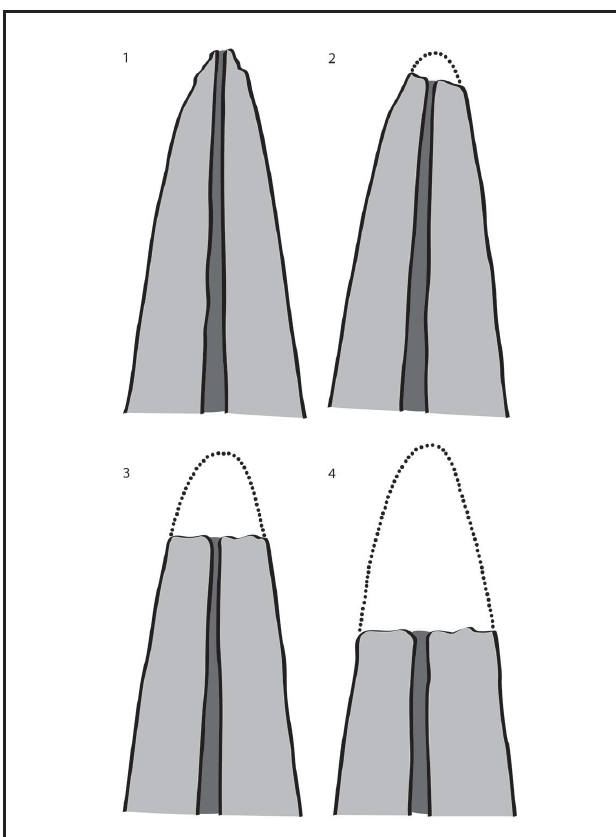
Fig. 1. Classification of the levels of root resorption during orthodontic treatment, according to Levander and Malmgren 23